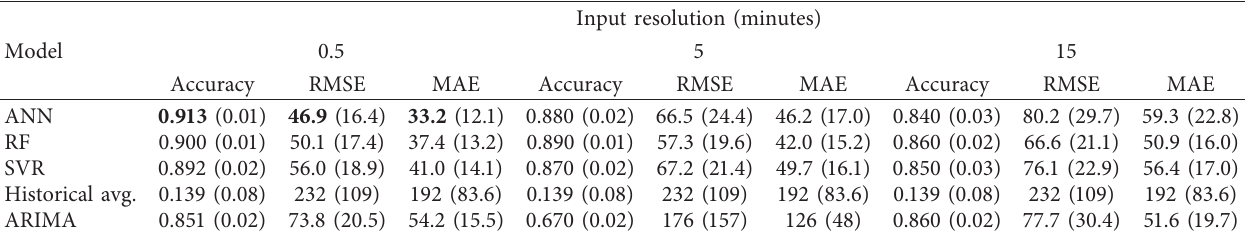
Figure 3: Accuracy and MAE at different times of the day. Shaded areas are the 95% confidence intervals across days in the test set. (a) Volume predictions. (b) Occupancy predictions. Table 4: Traffic volume prediction under nonrecurring congestion conditions.